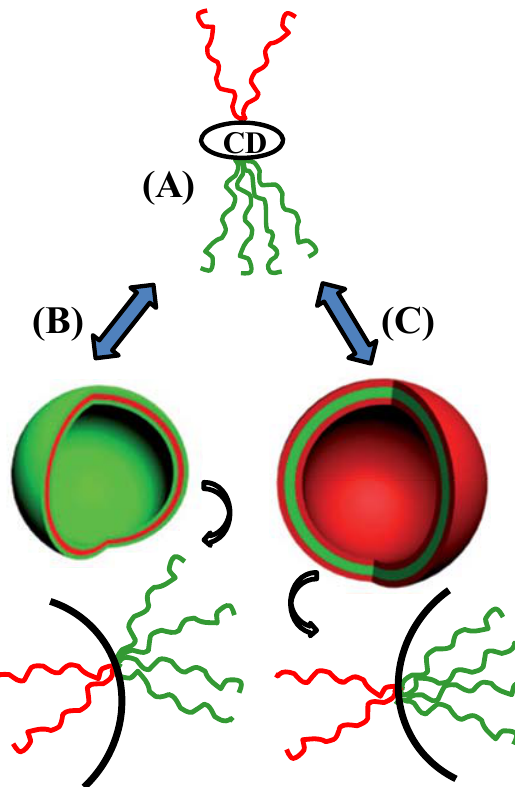
Scheme 3. Schematic representation of stimuli-responsive self-assembly of PDEAEMA PNIPAM star copolymer: (A) Unimers at pH 4 and 25 °C. (B) Vesicles at 7 14 pH 10 and 25 °C. (C) Inverted vesicles at pH 4 and 45 °C. The number of arms has been simplified. The scheme was inspired by